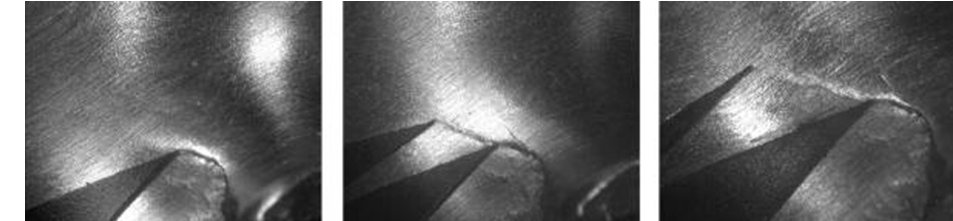
Figura 9: Fotografie ingrandite di una